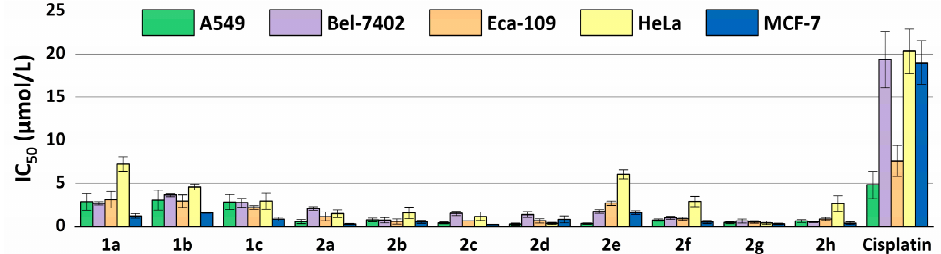
Figure 5. IC 50 values ( μ M) from the dose-response assay of compounds 1a – 1c and 2a – 2h and the reference compound cisplatin in the A549, Bel-7402, Eca-109, HeLa and MCF-7 cell lines, after an incubation time of 48 h. The results shown are means ± SD of quadruplicate experiments.